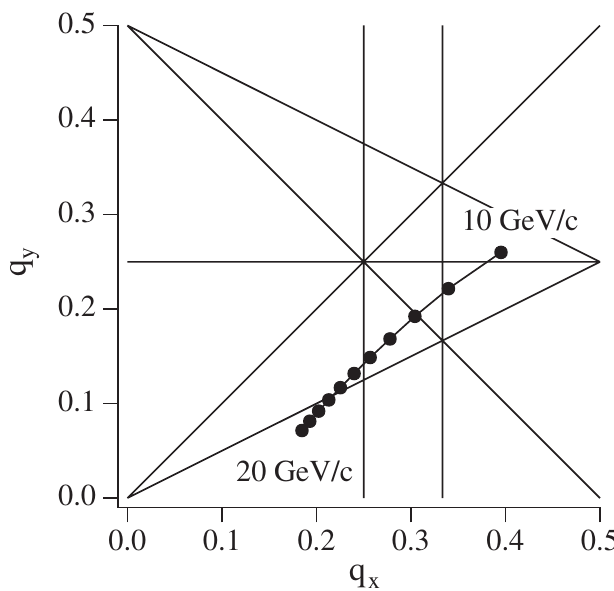
FIG. 1. Excursion of the cell tune from injection to extraction. Filled circles are marked every 1 GeV =c . Structure resonance lines up to fourth order are also